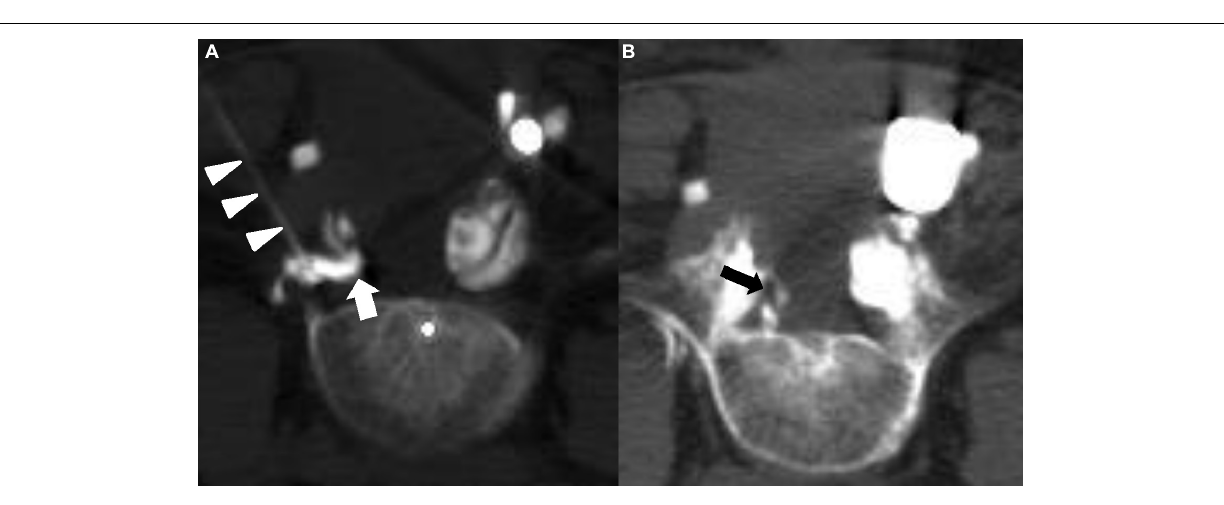
Frontiers in Medicine |